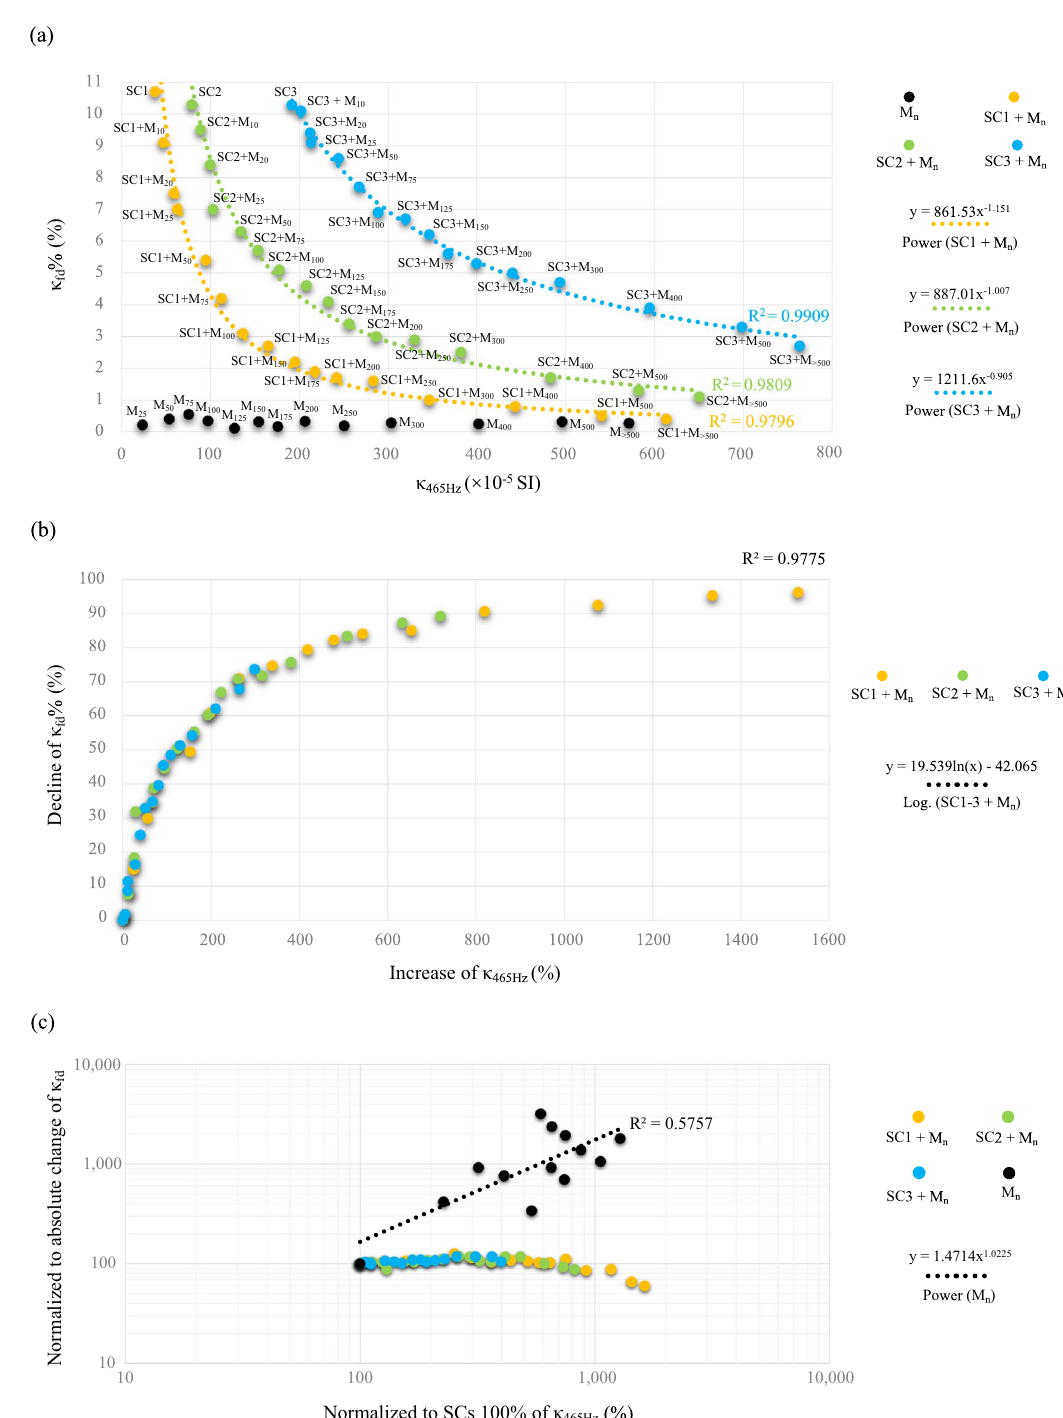
Figure 1. Plots for the experimental data on magnetite/maghemite (M n ) and soil concretion (SC1-3) samples: ( a ) volume magnetic susceptibility (κ 465Hz ) vs. percentage frequency-dependent magnetic susceptibility (κ fd %); ( b ) percentage increase in κ 465Hz vs. percentage decline in κ fd %; ( c ) bi-logarithmic plot of normalized to SCs of κ 465Hz vs. normalized to absolute change of frequency-dependent magnetic susceptibility (κ fd